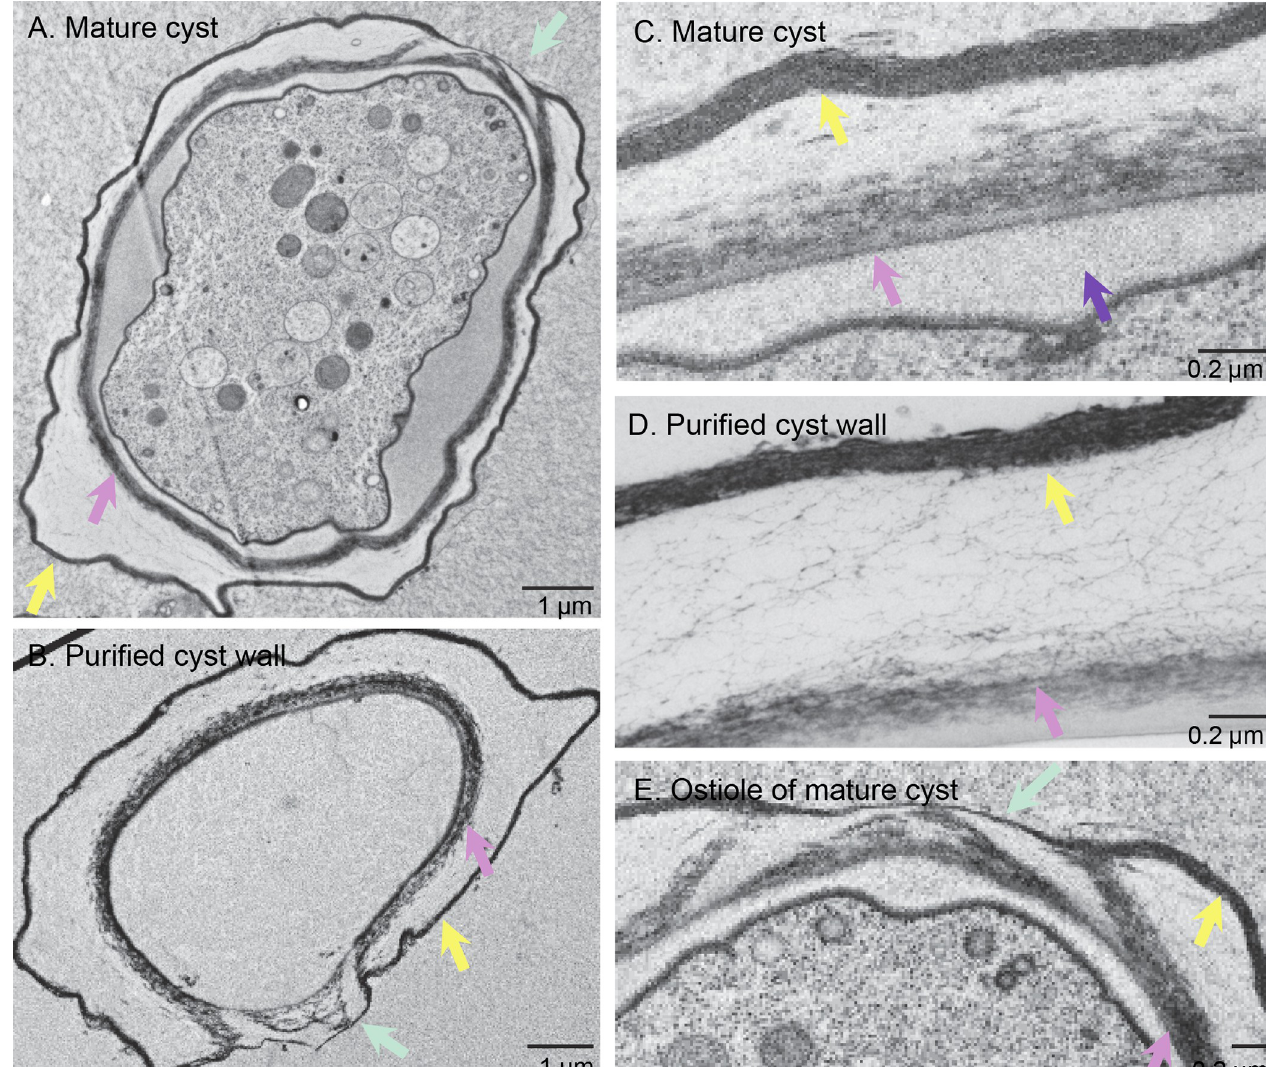
Fig 1. TEM showed purified A . castellanii cyst walls retained endocyst and ectocyst layers and ostioles. A, B. A mature cyst and a purified cyst wall had an outer ectocyst layer (yellow arrows), an inner endocyst layer (pink arrows), and ostioles (turquoise arrows) that connect the layers. Endocyst and ectocyst layers had the same appearance in mature cysts (C) and purified cyst walls (D). Purified cyst walls were missing amorphous material (purple arrow) between the wall and the plasma membrane of mature cysts. E. At the edge of the ostiole of a mature cyst, the endocyst layer bifurcated, and the outer branch met the ectocyst layer. In the center of the ostiole, the ectocyst layer formed a narrow cap over the inner branch of the endocyst layer. Scale bars as marked on